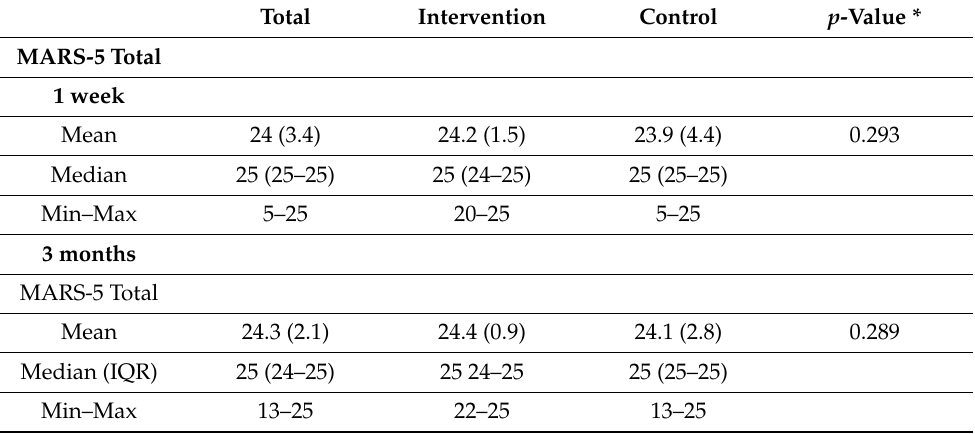
Table 4. Comparison between intervention group and control group for medication adherence at 1 week and 3